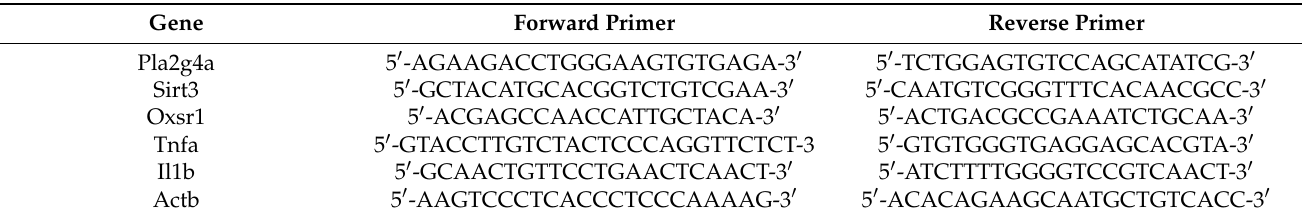
Table 1. Primer sequences for SYBR Green